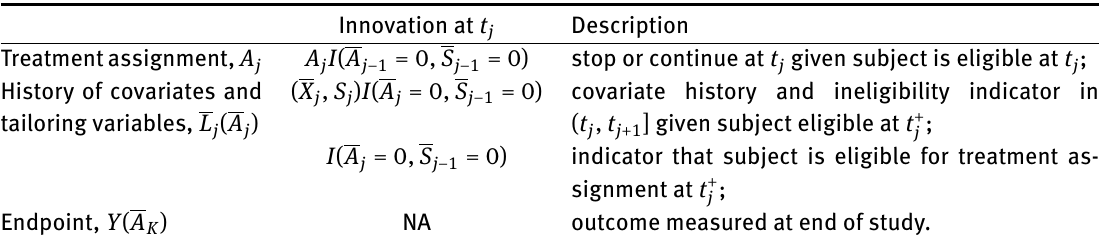
denotes the moment just after t j j